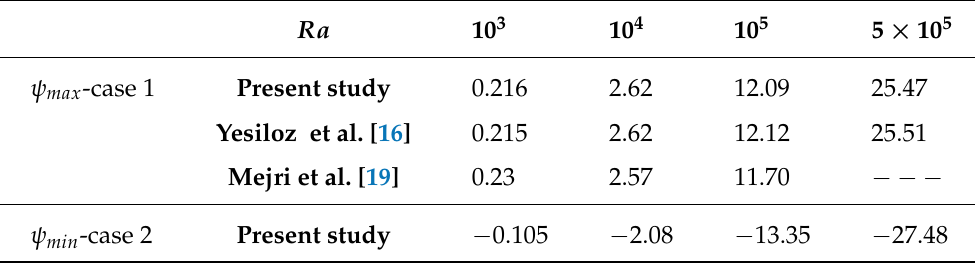
Table 2. Values of ψ max for case 1 and ψ min for case 2 for different Ra .